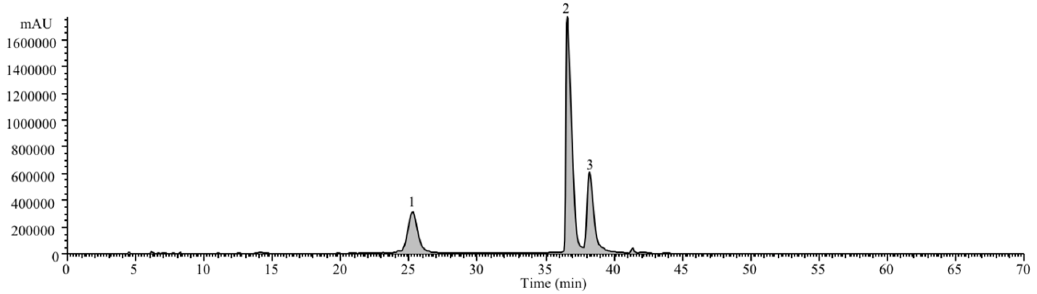
Figure 1. Chromatogram of identified anthocyanins in Sambucus nigra . 1: cyanidin-3- O -sambubioside- 5- O -glucoside; 2: cyanidin-3- O -sambubioside; 3: cyanidin-3- O -glucoside.